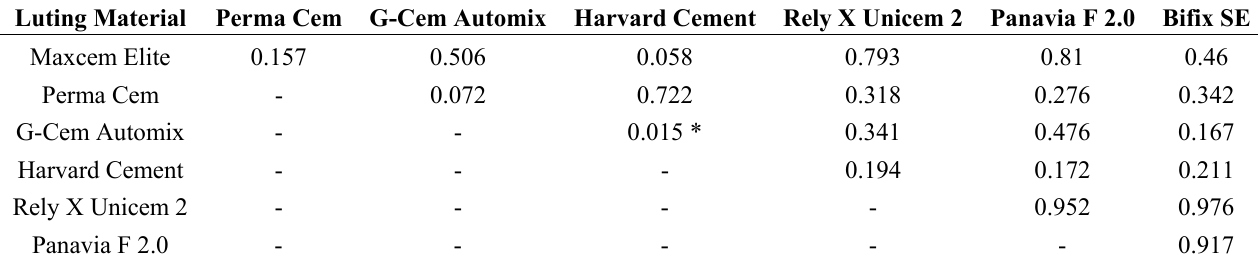
Table 7. Summary of the statistical comparison of the microleakage between the different luting materials in dentin.